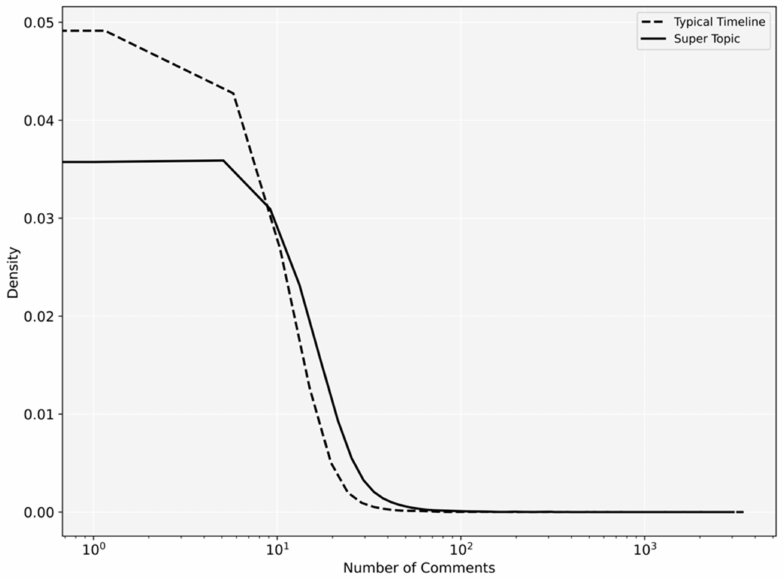
Figure 4. Probability density of comments users received in Depression Super Topic and regular